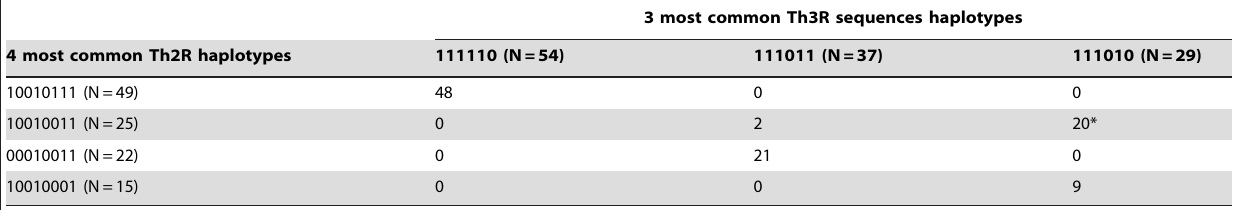
3 most common Th3R sequences haplotypes